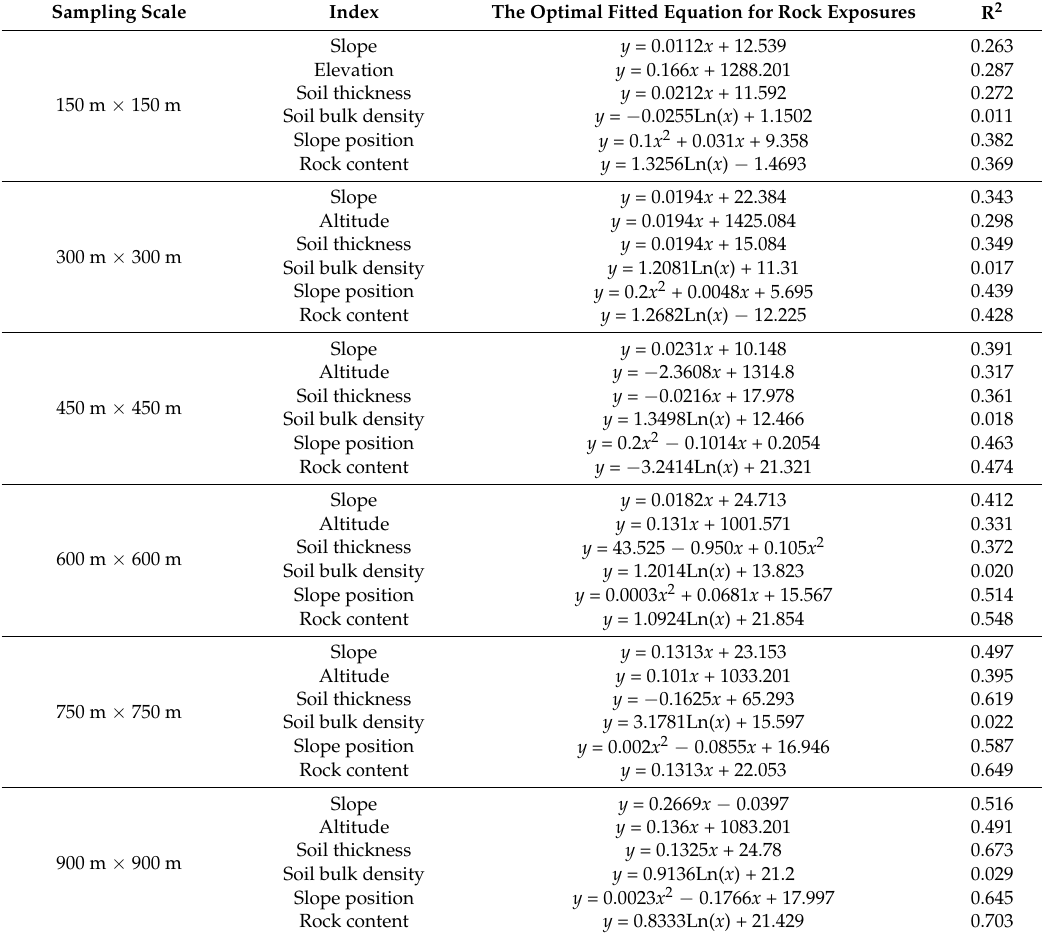
Table 4. Optimal fitted equations of factors influencing rock exposures at different sampling